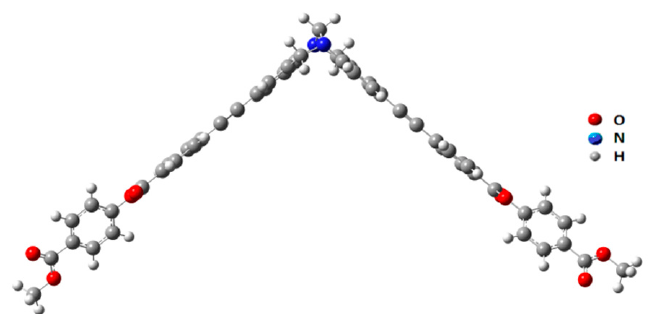
Figure 1. Ball-and-Stick model of compound 8 .